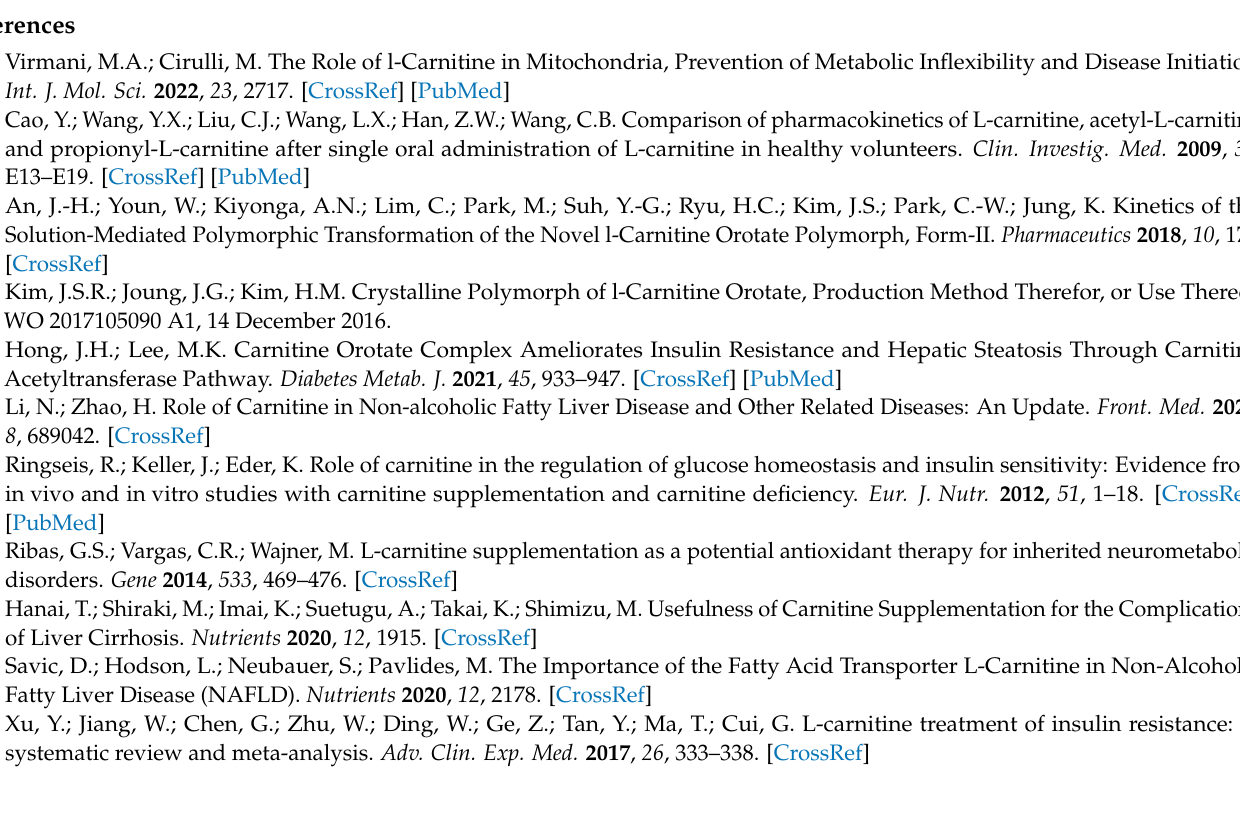
Figure S6. Sensitivity analysis of the effect of L -carnitine (or acetyl- L -carnitine) supplementation on post-treatment AST and ALT levels with jackknife sensitivity analysis showing the robustness of